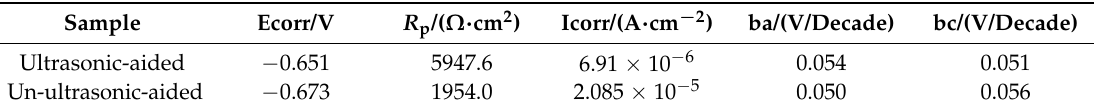
Table 3. Electrochemical test results of